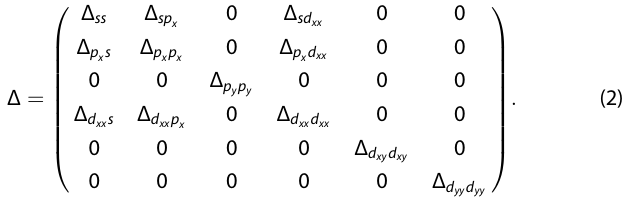
eigenstates α R (cid:2) j